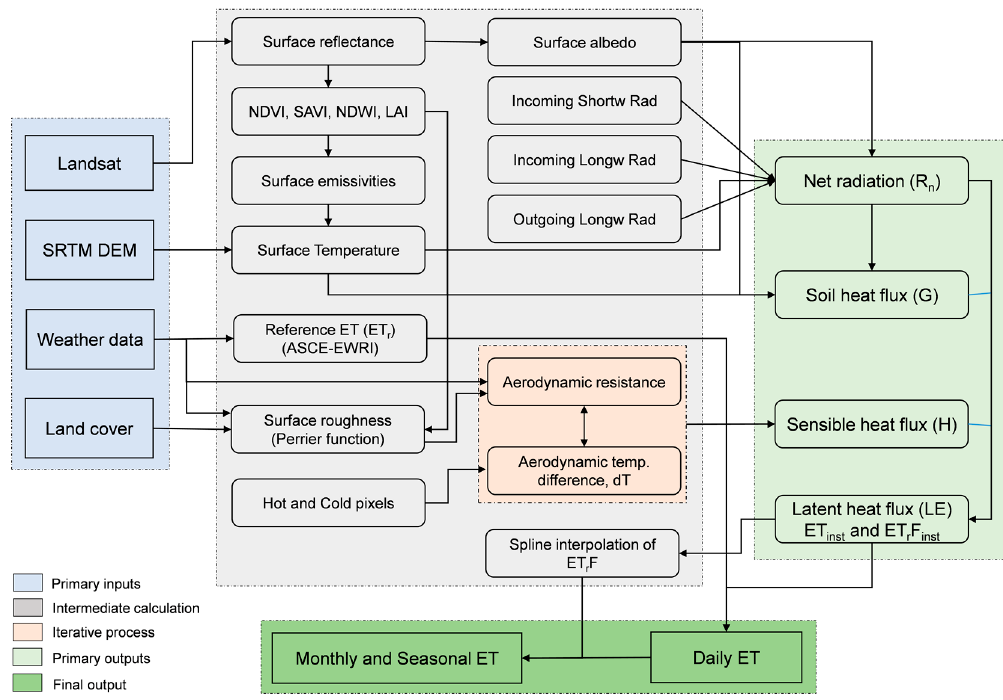
Figure 3. Flowchart of METRIC evapotranspiration estimation.